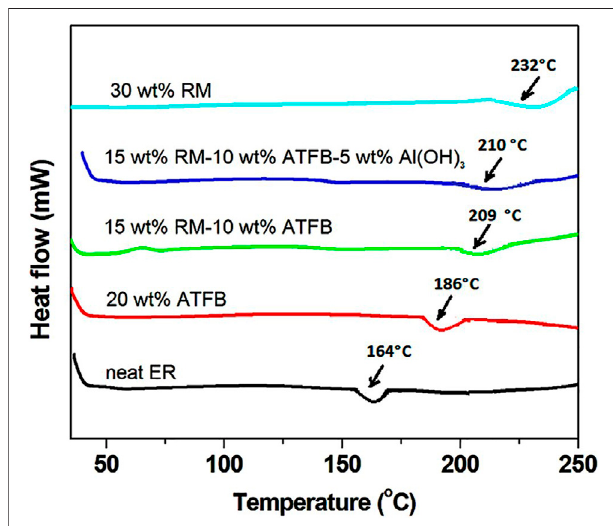
FIGURE2| Differentialscanningcalorimeter(DSC)curvesoftheneatER and ER composites with different contents of ATFB, RM, and Al(OH) 3 (Kusakli et al., 2020).